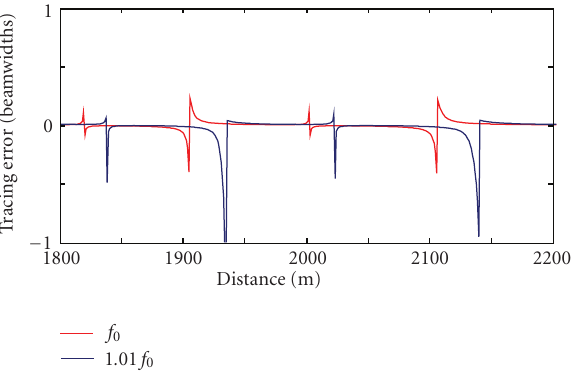
Figure 12: Error function, as a function of elevation error, for two di ff erent working frequencies di ff ering by 1% when the crossfeed comparator is a ff ected by a 2 ◦ error on the Elevation secondary channel.